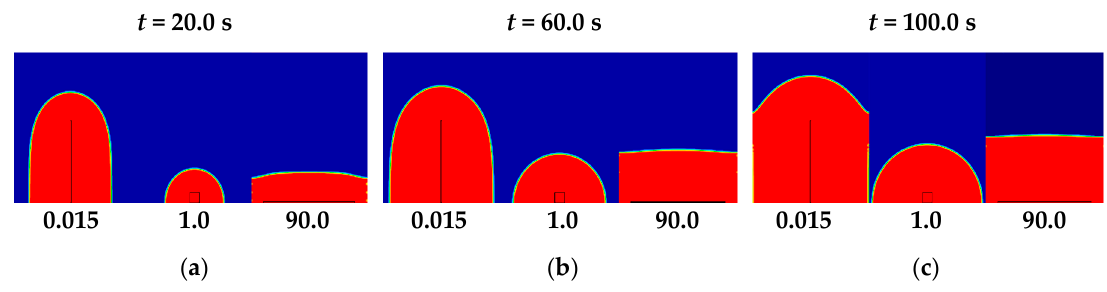
Figure 7. Resin volume fraction for ϕ = 0.01 and three different ratios of L 0 / H 0 : ( L 0 / H 0 ) o = 0.015, L 0 / H 0 = 2.0, L 0 / H 0 = 90.0 as a function of time: ( a ) t = 20.0 s, ( b ) t = 60.0 s, ( c ) t = 100 s.